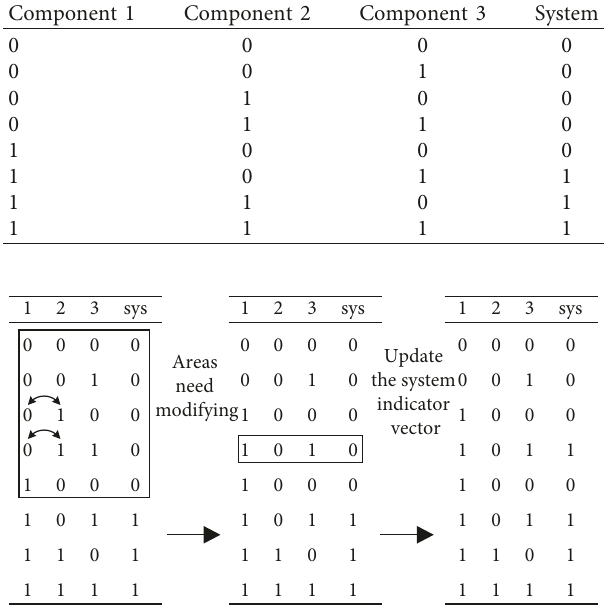
Figure 2: Transformation of the truth table.